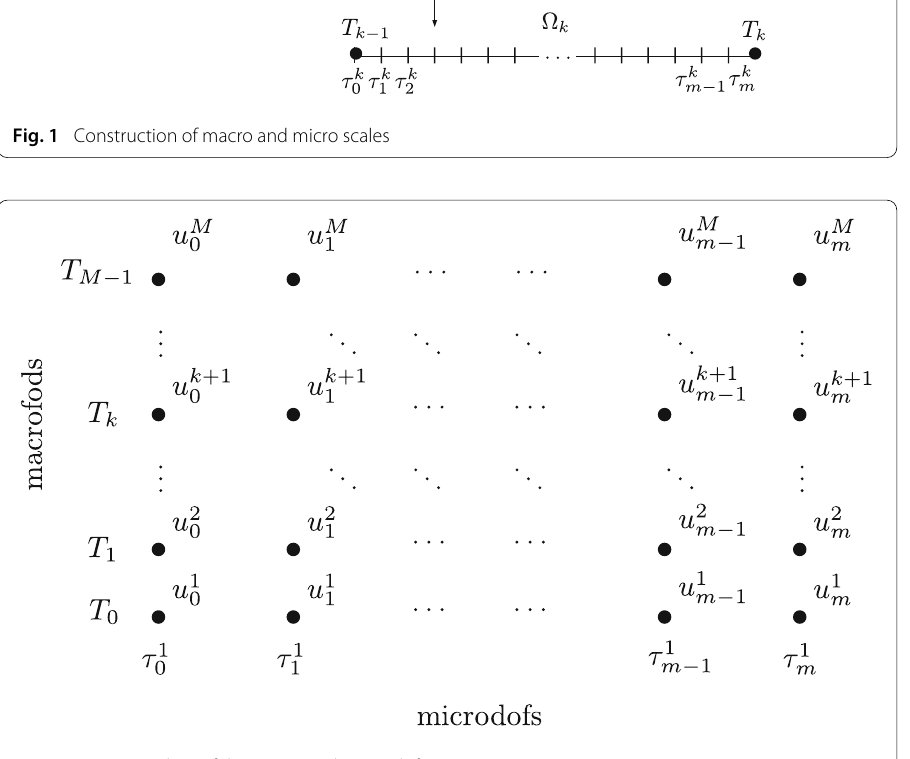
Fig. 2 Tensor product of the macro and micro